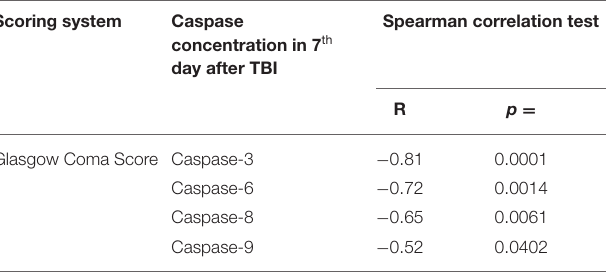
TABLE 1 | The correlation between selected caspases concentration and the Glasgow Coma Score (GCS). Scoring system